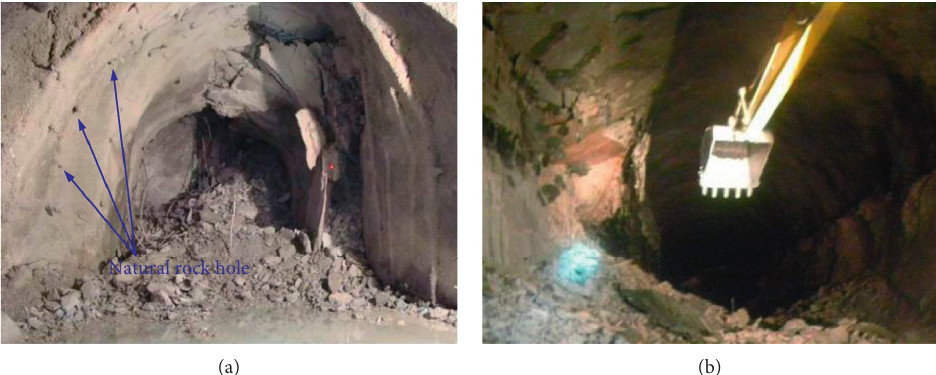
Figure 1: Rock bursts in tunnel excavation [23]. (a) Rock bursts at tunnel heading. (b) Rock mass collapse at 100m from tunnel